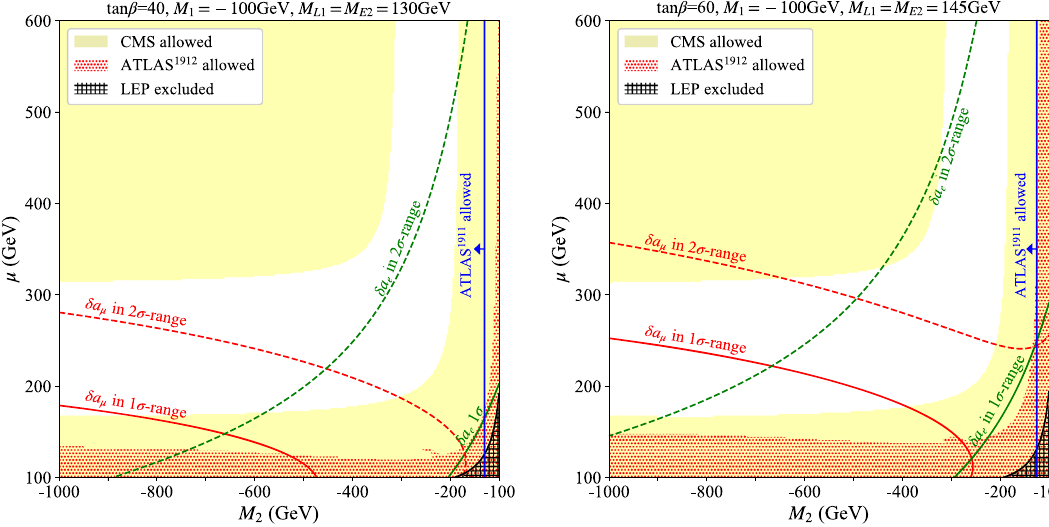
Fig. 3 The MSSM parameter space for a joint explanation of muon/electron g − 2, showing the LHC and LEP constraints. The constraints are from ATLAS1912 [44], ATLAS1911 [63], CMS [62] and LEP [43]. Other constraints from the LHC [64,65] are not shown